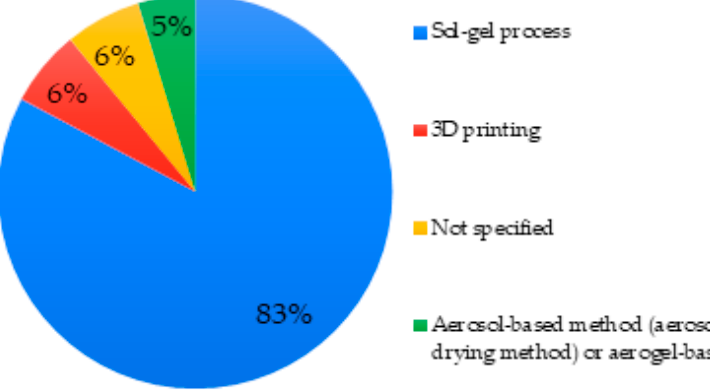
Figure 3. Mesoporous bioactive glass (MBG) synthesis methods used in studied